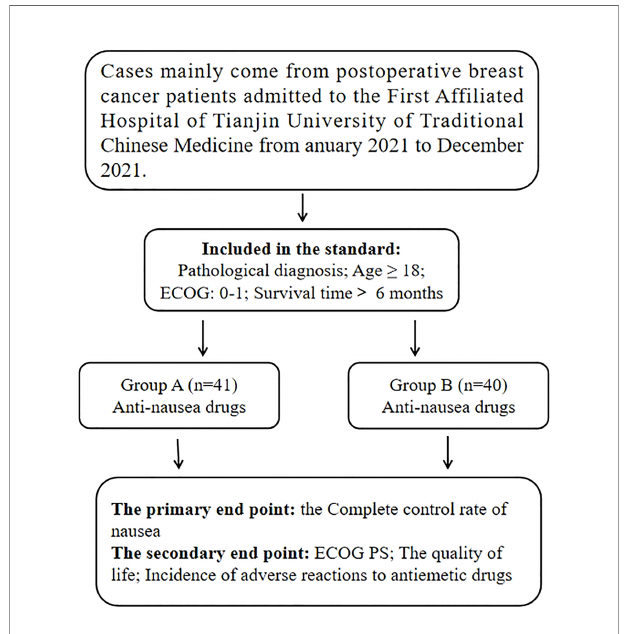
FIGURE 1 | The fl ow chart of this